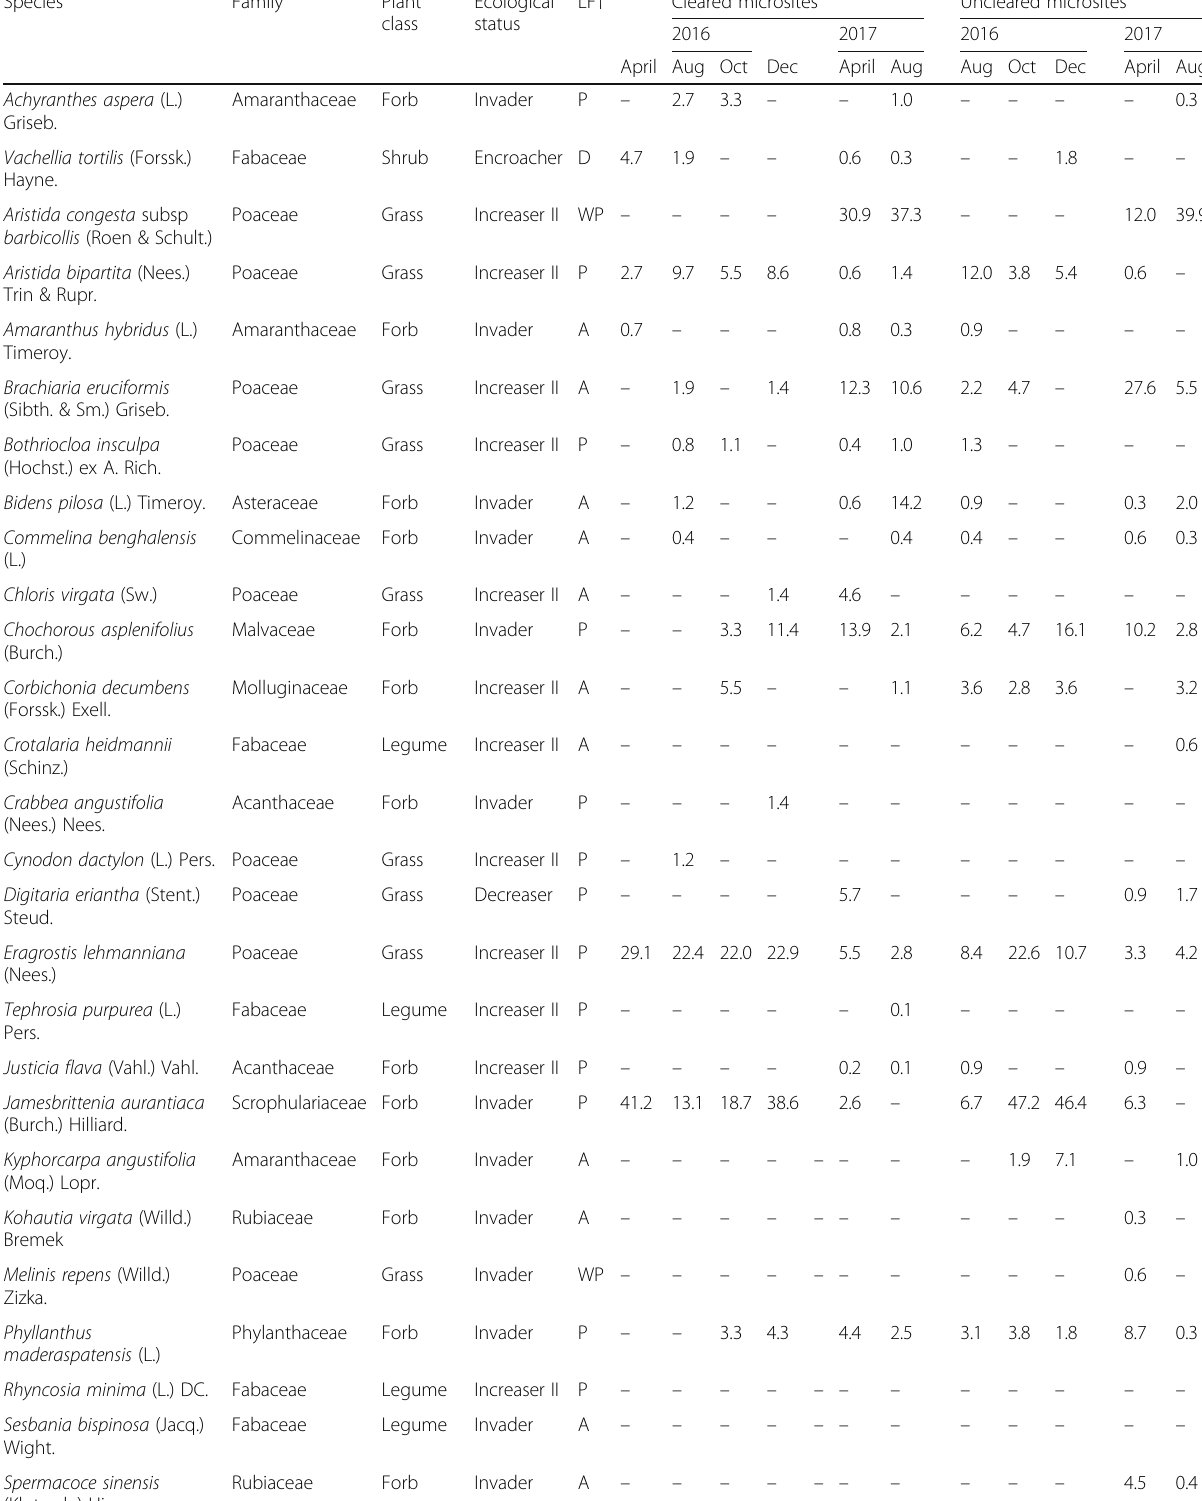
Table 1 Plant species abundance (%) and richness of the soil seed bank over time in bush-cleared and uncleared microsites